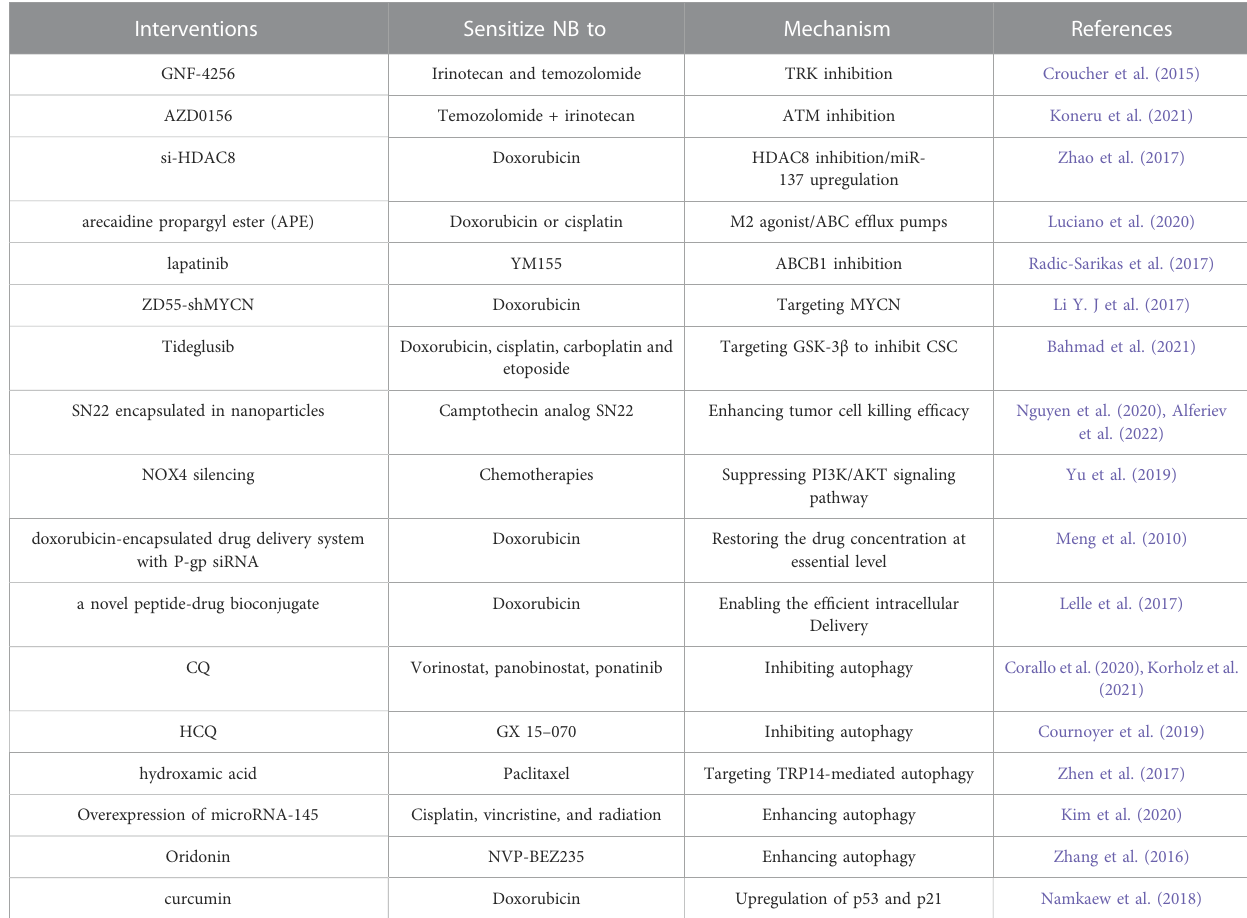
TABLE 2 Reversal strategies against therapy resistance of